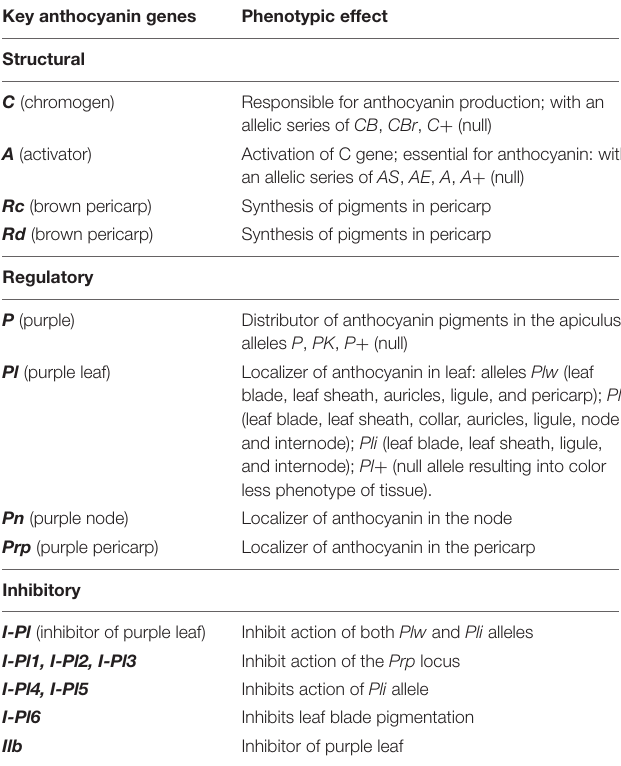
TABLE 3 | List of structural, regulatory, and inhibitory genes involved anthocyanin pathway with their phenotypic effects. Key anthocyanin